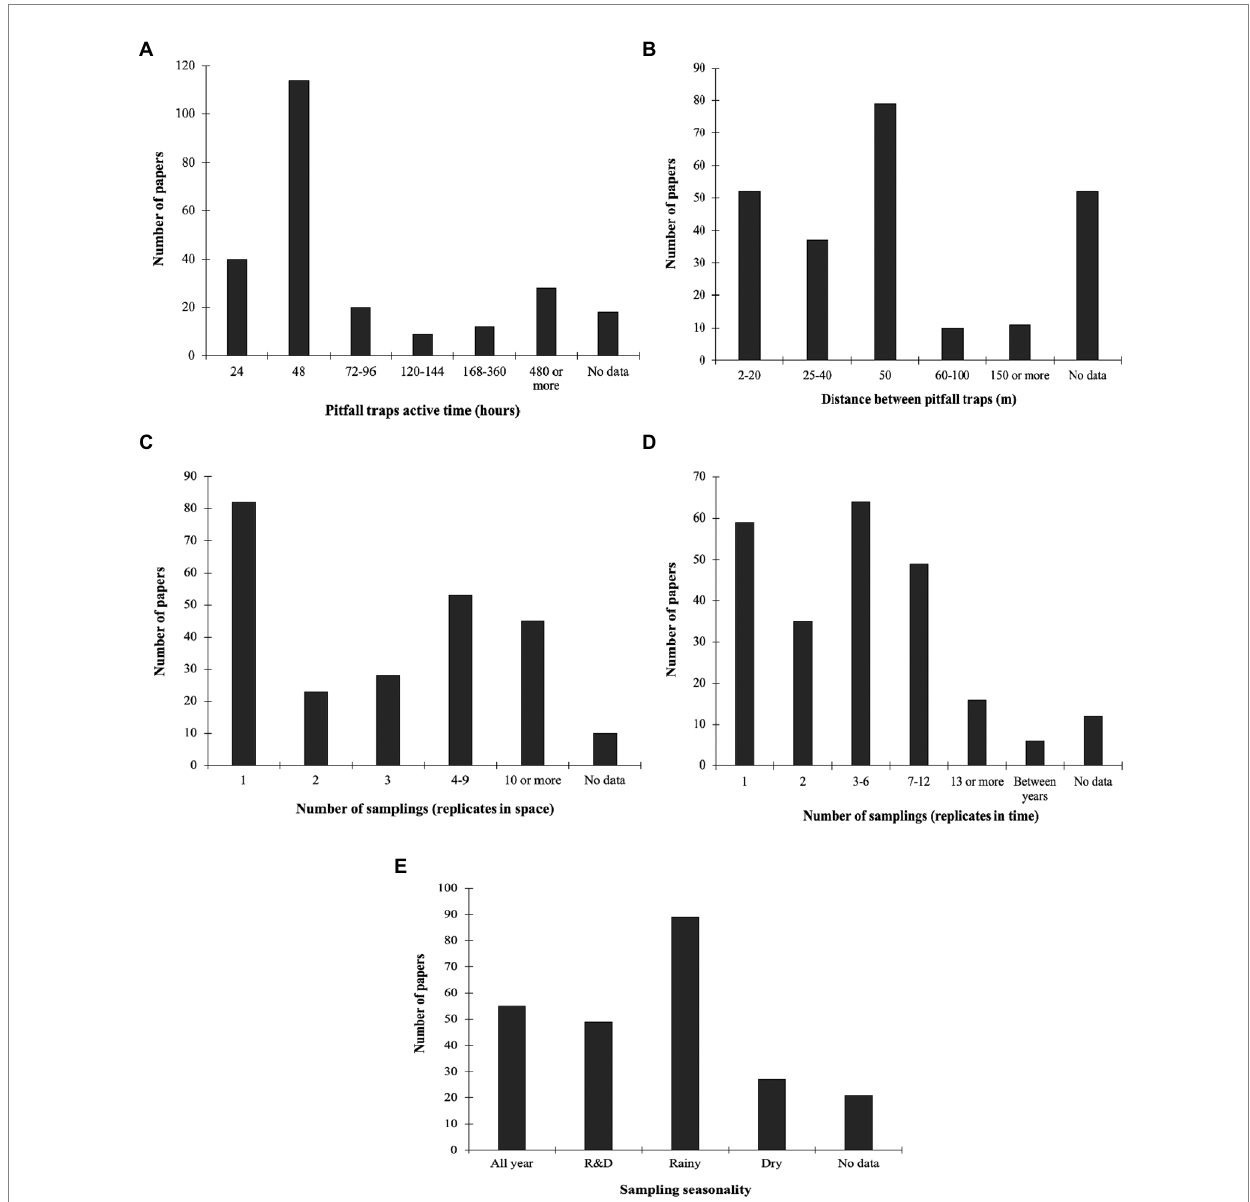
FIGURE 4 Number of published papers on dung beetle sampling compiled in the Neotropics according to different variables: (A) Pitfall traps active time; (B) Distance between pitfall traps; (C) Number of samplings in space; (D) Number of samplings in time; and (E) Sampling